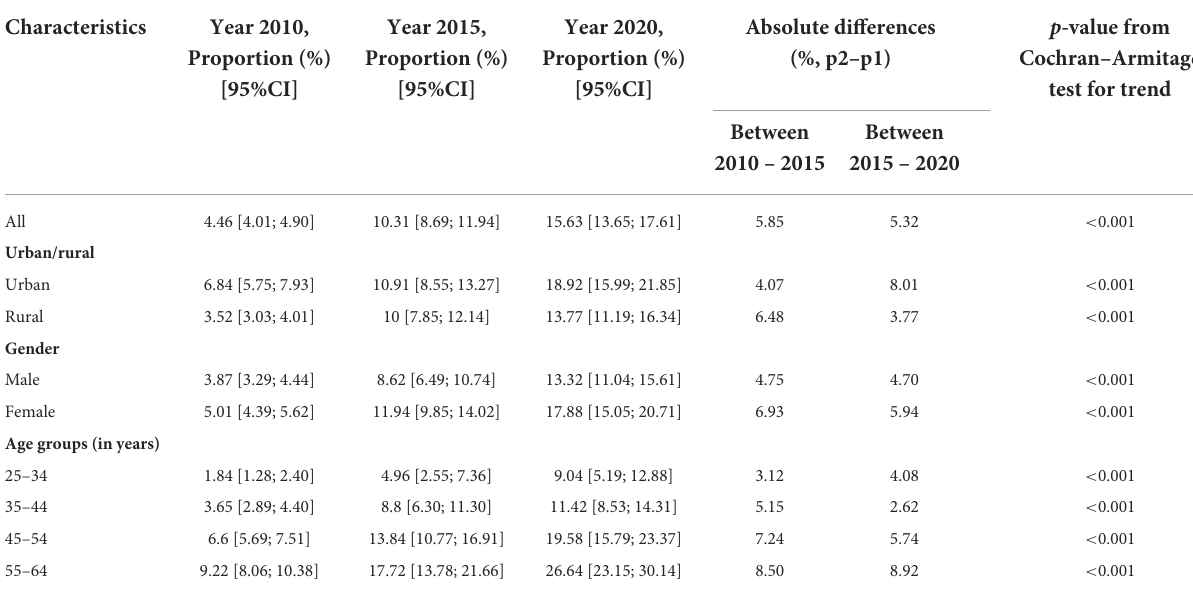
TABLE 4 Absolute changes in the prevalence of elevated blood lipids over time.